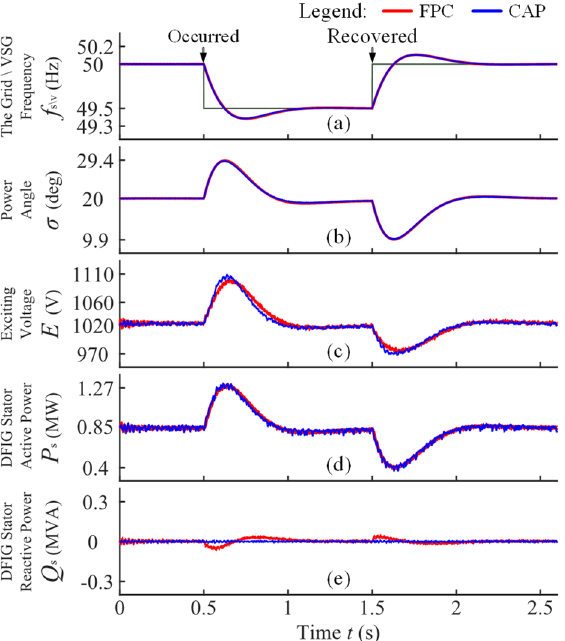
Figure 9. Inertial operational waveforms of a DFIG-VSG at a low wind speed: ( a – e ) The